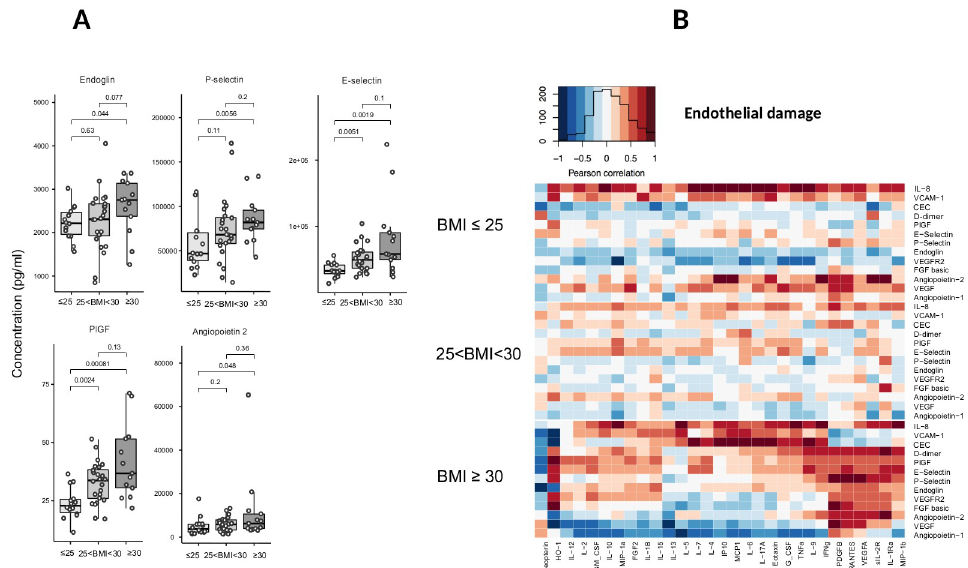
Fig 5. (A) Box plots illustrating the plasma levels of endothelial activation markers (IL-8, endoglin, E and P-selectins, PIGF, Ang-2) according to BMI (BMI � 25, 25 < BMI < 30, BMI � 30). (B) The Spearman correlation heatmap depicts the negative (blue), positive (red), and no (white) correlation between plasma markers of endothelial activation and the blood cytokines levels in COVID-19 patients (n = 38) according to BMI (BMI � 25, 25 < BMI < 30, BMI �